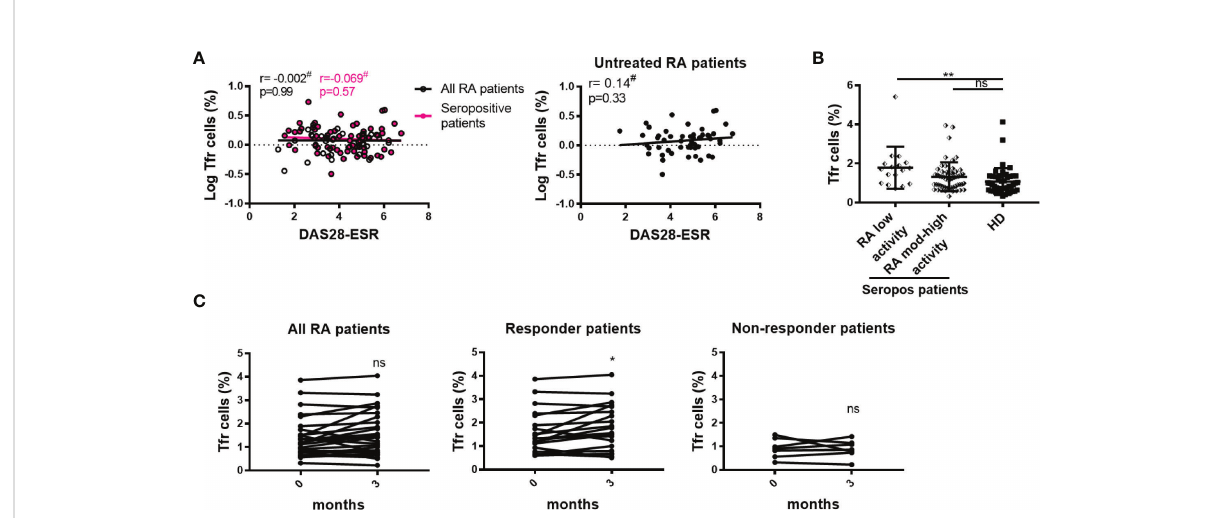
FIGURE 7 Relationship between Tfr cells and the activity of the disease. (A) Correlation between DAS28-ESR and Tfr cell frequency in all RA patients (n=99, empty black circles and line) or in seropositive patients (n=72, pink circles and line left), and in untreated RA patients (n=52, right). (B) Frequency of Tfr cells in seropositive RA patients (Seropos, n=72) with low (n=17) or moderate-high (n=55) disease activity and HD (n=46). (C) Frequency of Tfr cells at baseline (0 months) and after 3 months of treatment in all RA patients (n=27) (left), in responder (n=20) (middle) and non- responder (n=7) (right) RA patients. Symbols represent individual subjects. # Pearson ’ s correlation coef fi cient r and P values are shown in (A) . Lines of best fi t were drawn. Mean ± DS is shown in (B) . One-way Analysis of Variance (ANOVA) followed by Bonferroni Multiple Comparisons Test were calculated in (B) . P values were determined by Paired samples T-Test in (C) . Two-tailed probability * p < 0.05 , ** p < 0.01 , ns, not signi fi